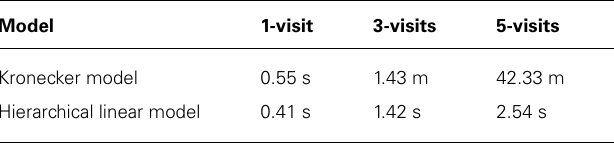
Table 2 | CPU time for running analysis with three mean models at each